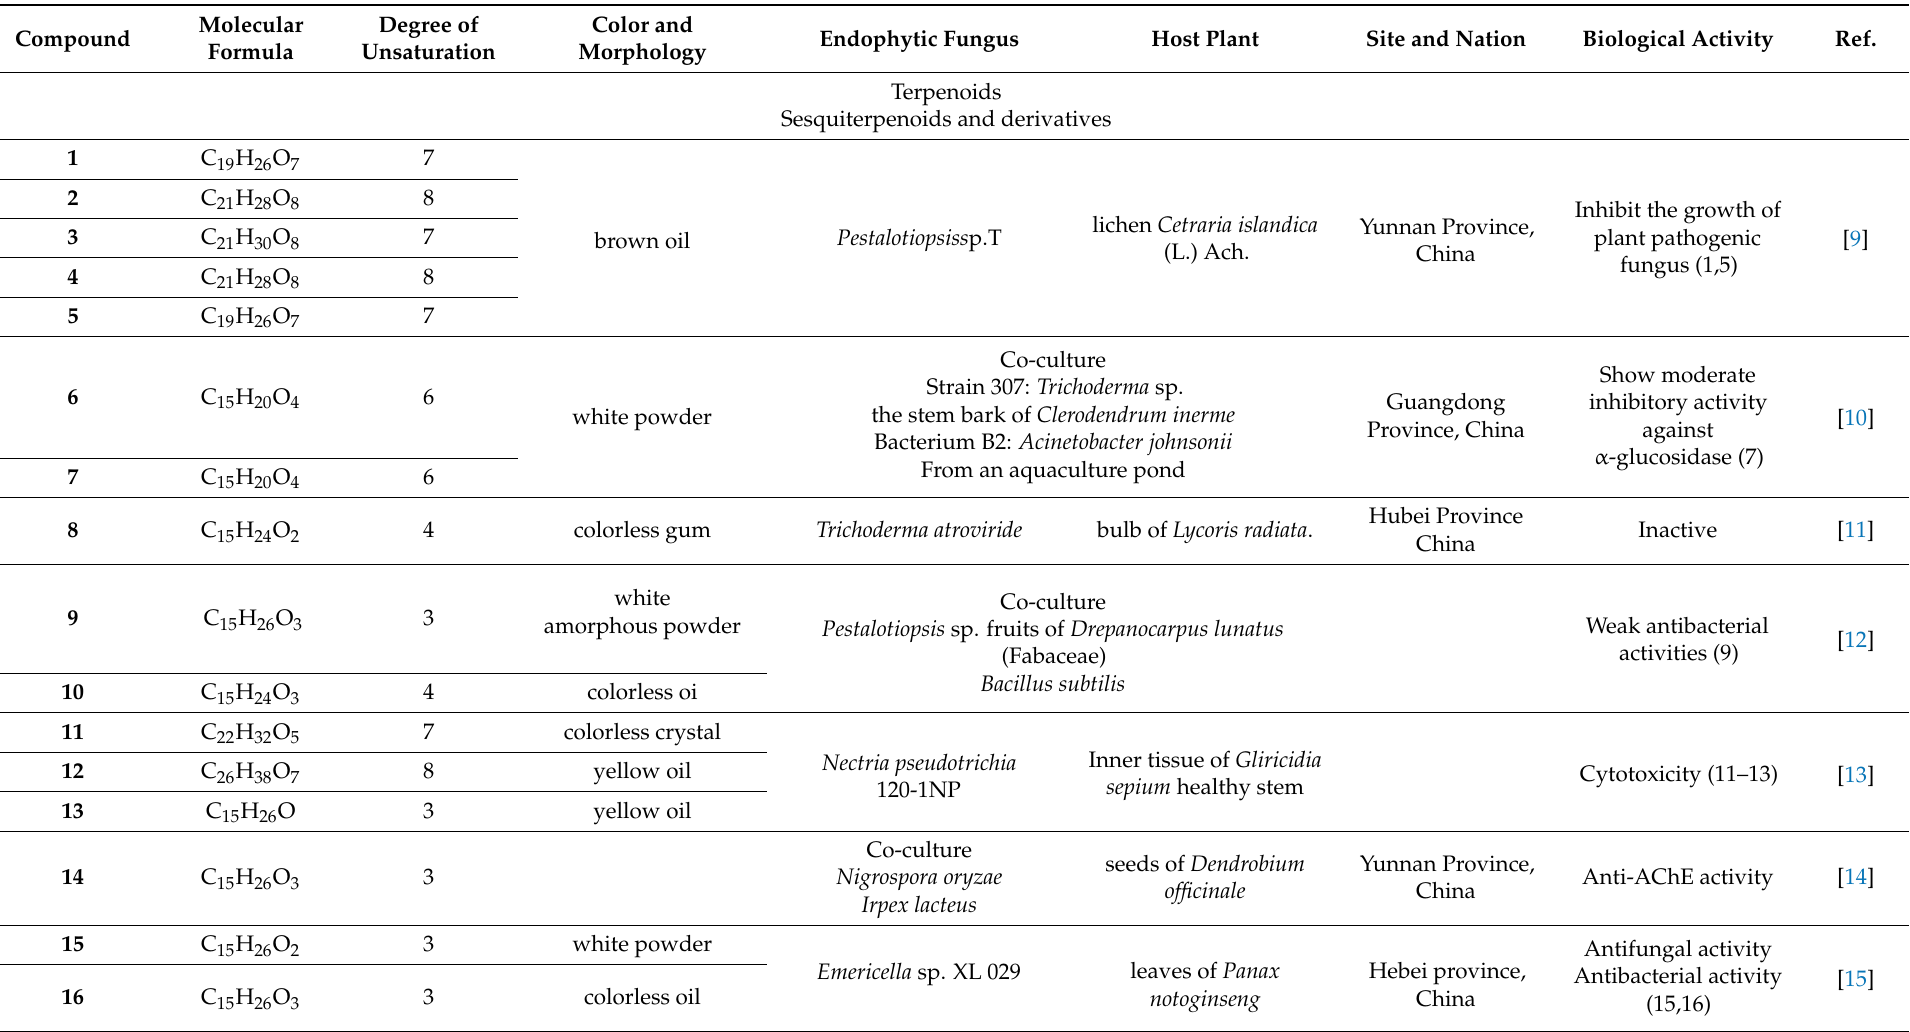
Table 1. Brief summary of new